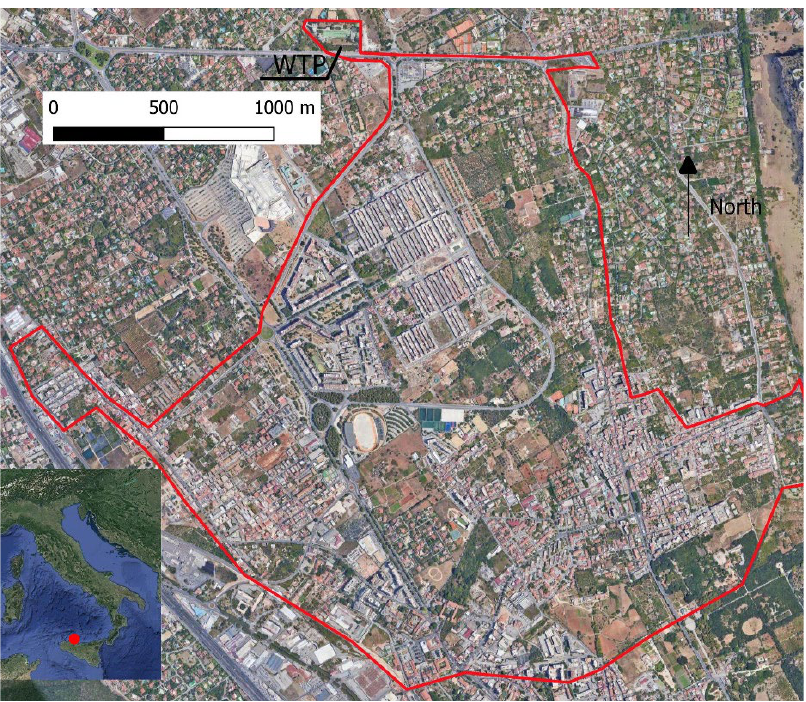
Figure 3. Satellite view of 2D case study boundary outline.